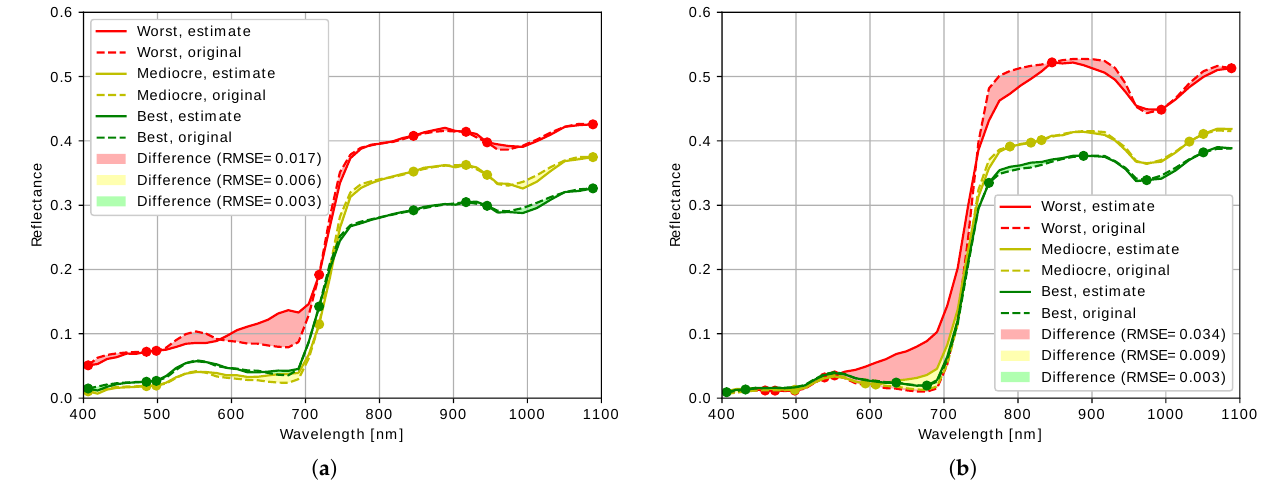
Figure 8. Selected reconstructed spectra from Ground_Full . ( a ) KSVD-BBS , ( b ) DCS-GM